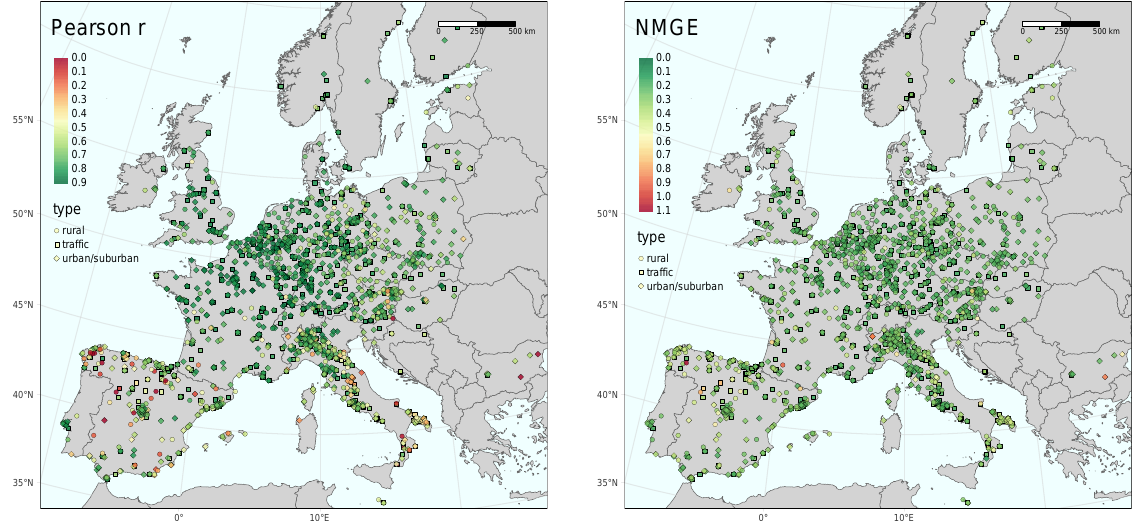
Figure 2. Linear correlation coefficients (Pearson r) and normalised mean gross error (NMGE) for the GAM predicted vs. observed daily mean values of NO 2 during March–July 2015–2019. Squares = traffic sites, diamonds = urban/suburban sites and circles = rural background sites. These maps show all stations before screening for r ≥